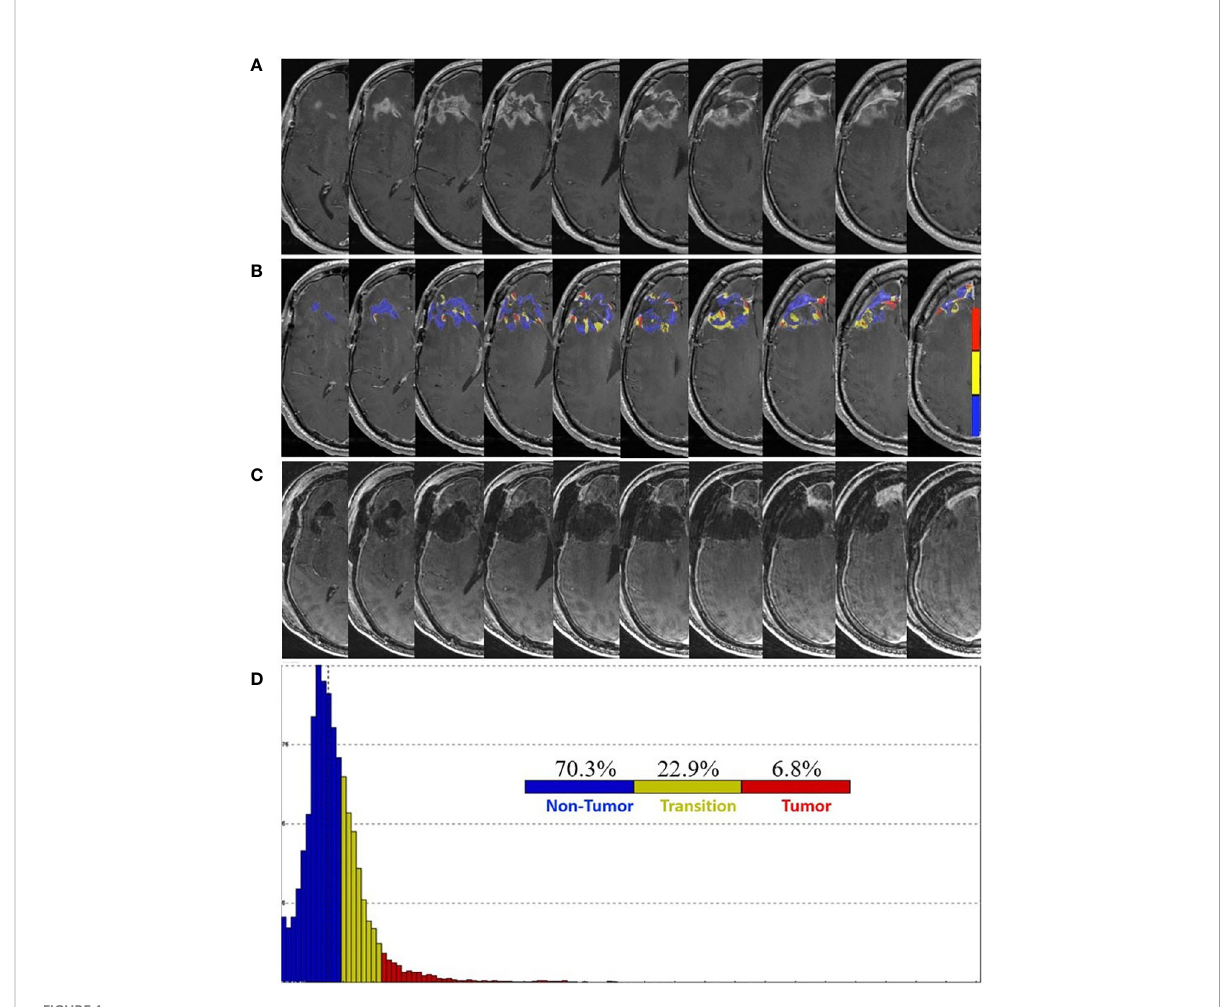
FIGURE 1 Pre- and post-surgery MRI. (A) Postcontrast T1-weighted MRI obtained 20 weeks following the completion of pLDR and two weeks before redo-surgery. (B) Corresponding maps of FTB superimposed on the postcontrast T1-weighted MRI images. The FTB maps show areas of active tumor (red), treatment effect (blue), and transitional zone (yellow). (C) Immediate post-operative postcontrast T1-weighted MRI demonstrating extent of resection. (D) Distribution of T1-weighted enhancement volume based on vascularization as measured by FTB